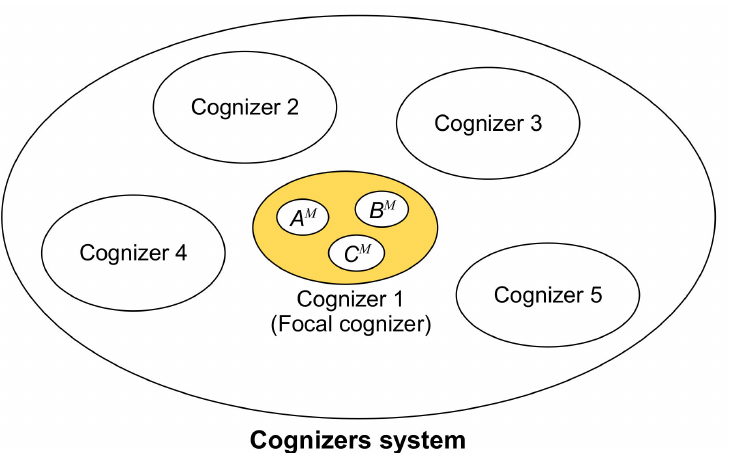
Figure 2. The cognizers-system model (CS model) assumes the whole set of cognizers in interaction, viewed from the meta-observer. The internalist, phenomenological model of this paper describes a focal cognizer (Cognizer 1: yellow circle) only, composed of cognizers at a lower level ( A M , B M , and C M are shown here for discussions in Section